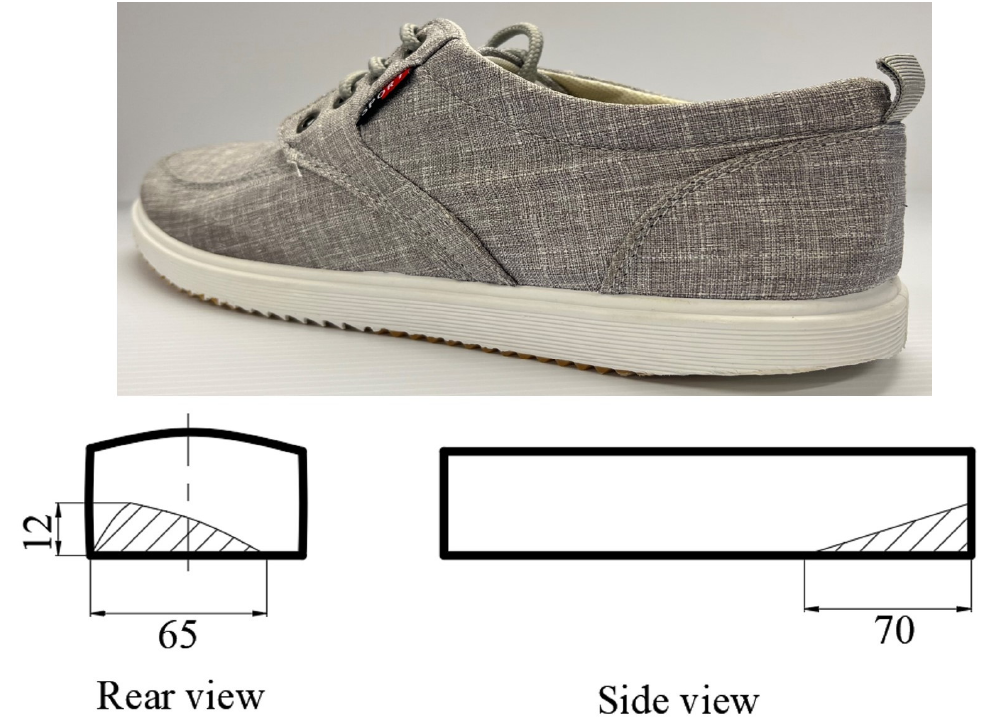
Figure 1. Schematic diagram of LHWS outsoles. LHWS: lateral-heel-worn shoes .